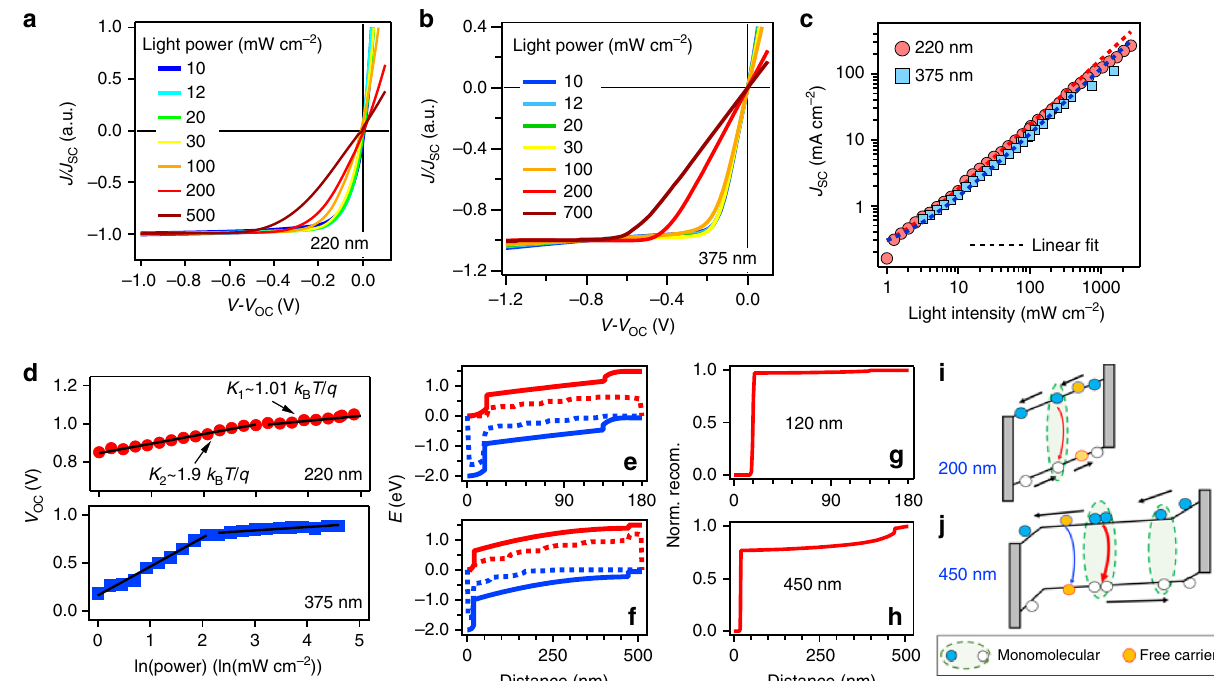
Fig. 3 Light intensity dependence with device J – V characteristics. Normalized light J – V curves for a device with absorber thicknesses of a 220 nm and b 375 nm under various illumination intensities. c J SC value as a function of light power over a wide illumination range. d V OC as a function of illumination intensities for two device thicknesses. e , f Calculated band energy as a function of fi lm thickness and g , h normalized recombination pro fi le as a function of distance in the device for two typical thicknesses. i , j Schematics illustrating the carrier recombination processes in thin fi lm and thick fi lm in the quantum well-layered perovskite